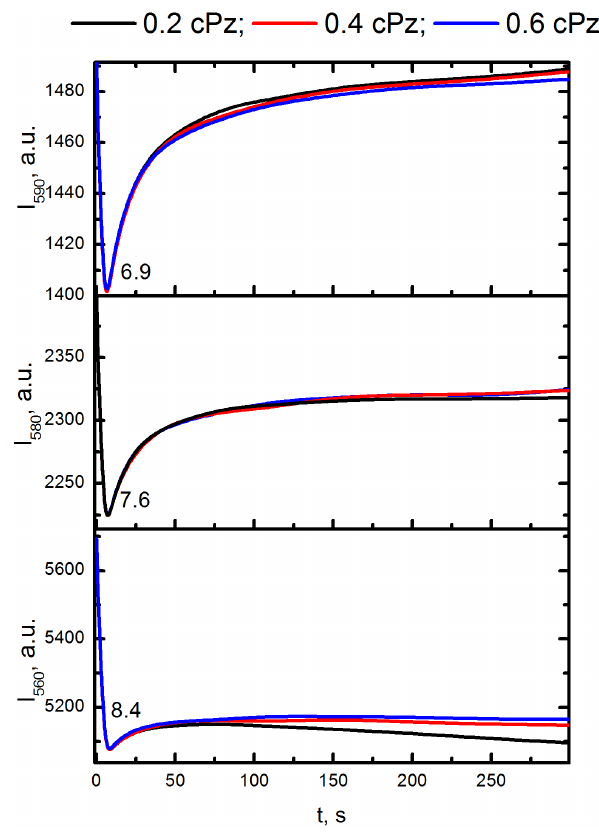
Fig. 4. Changes of bengal rose °uorescence spectrum intensity at 560, 590 and 580 nm to